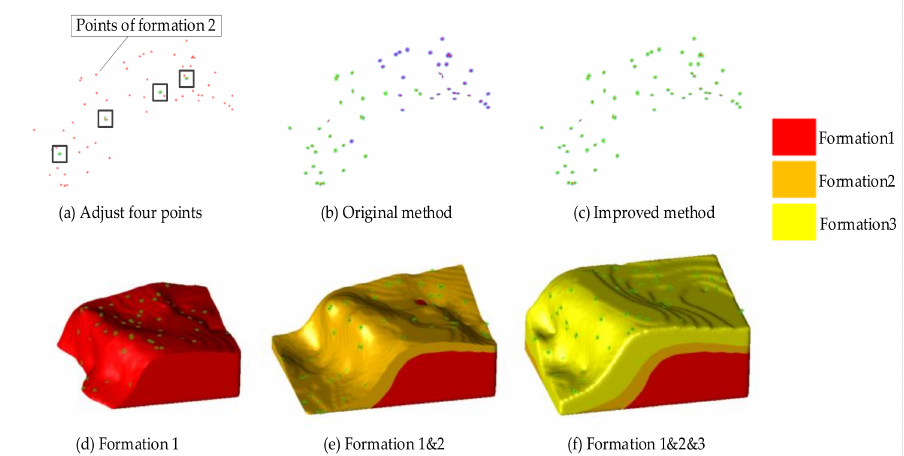
Figure 10. Normal estimation and modeling results of the third data set. ( a ) shows that the normal directions of the four points have been adjusted artificially. ( b ) is the normal estimation result obtained by using the original method. ( c ) is the normal estimation result obtained by using improved method in this paper. ( d – f ) show the geological modeling results obtained by using modeling method in this